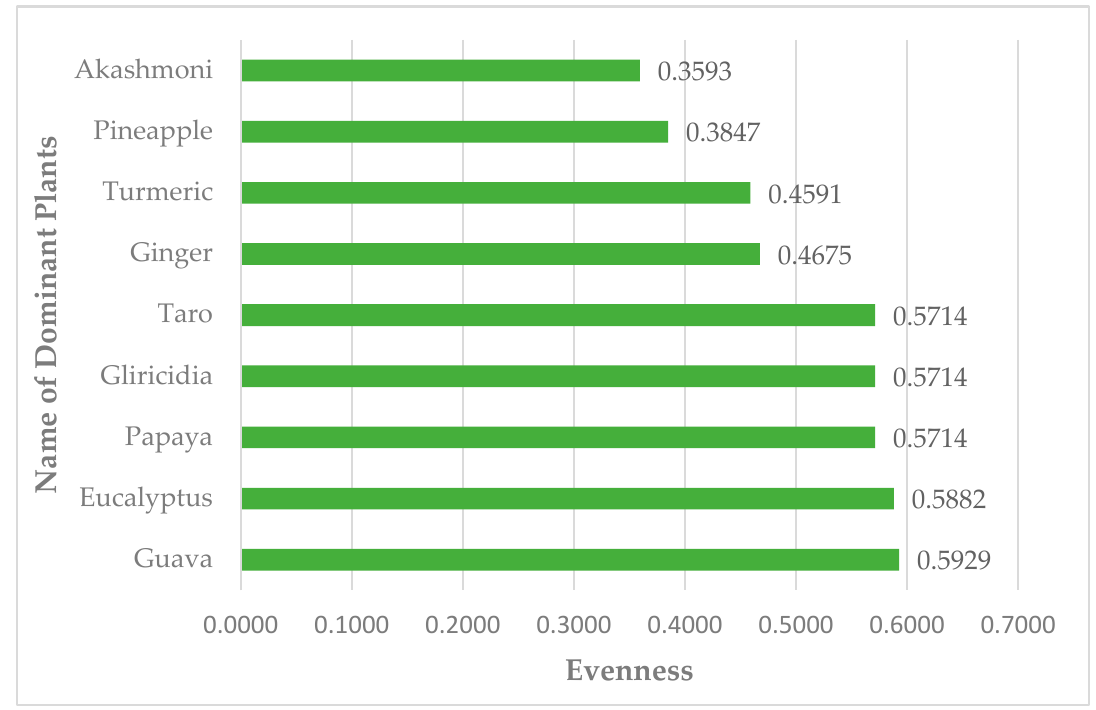
Figure 7. The Evenness of the dominant plant species in the Madhupur tract.